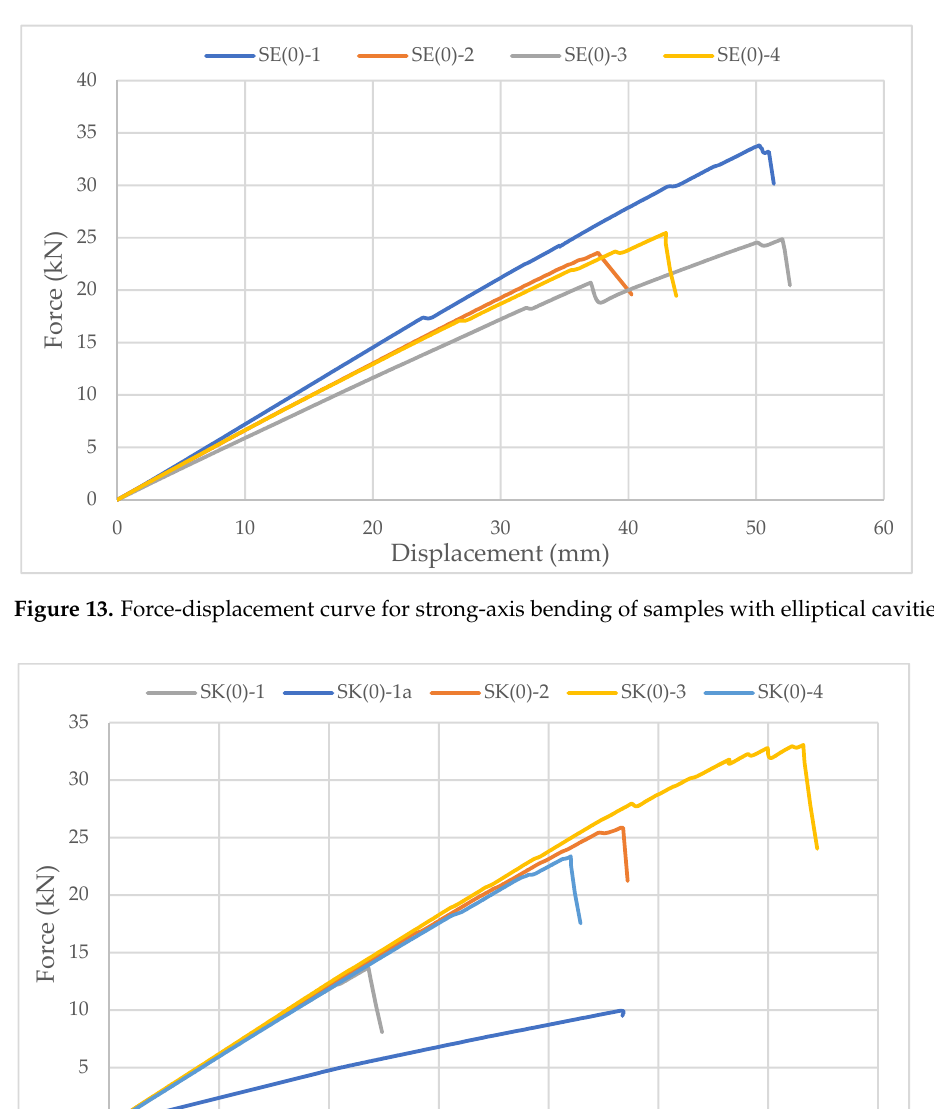
Figure 12. Timber beam during strong-axis bending experimental test.